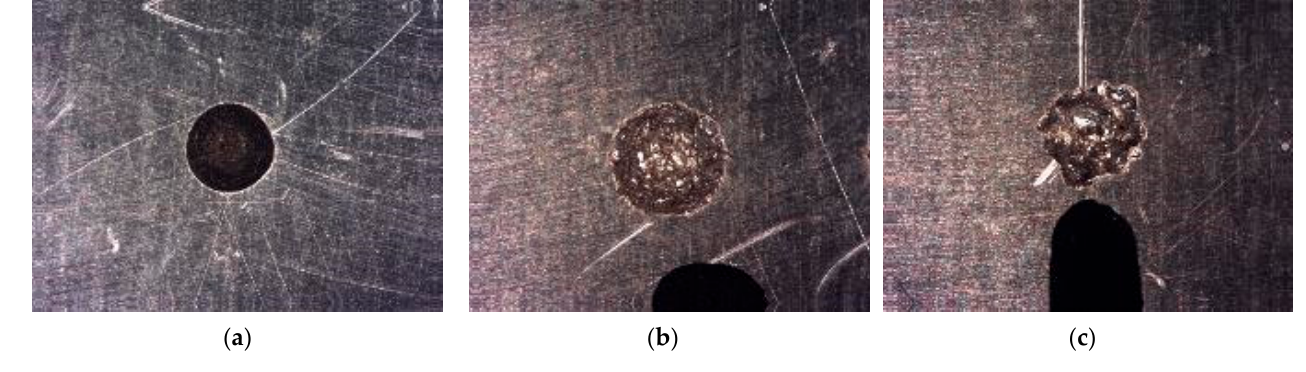
Figure 18. SEDM results. ( a ) VDI 0 ( b ) VDI 27 ( c ) VDI 40.